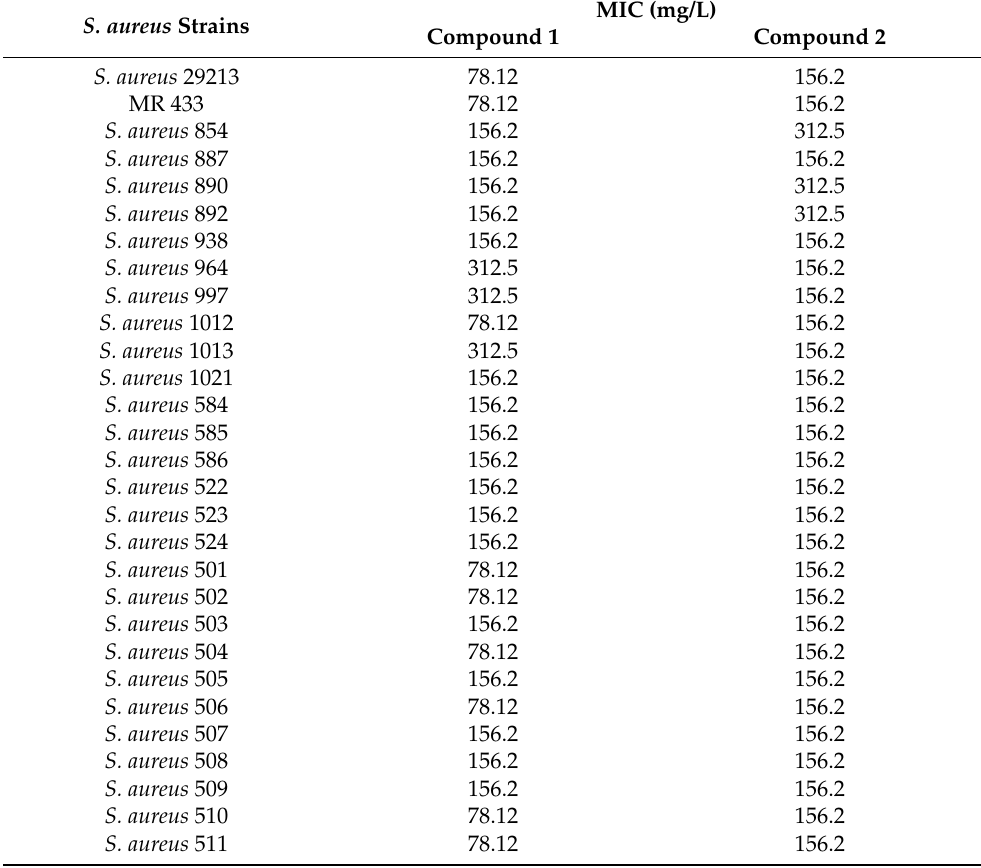
Table 2. The antimicrobial activity of compounds 1 and 2 toward multidrug resistant S. aureus strains.